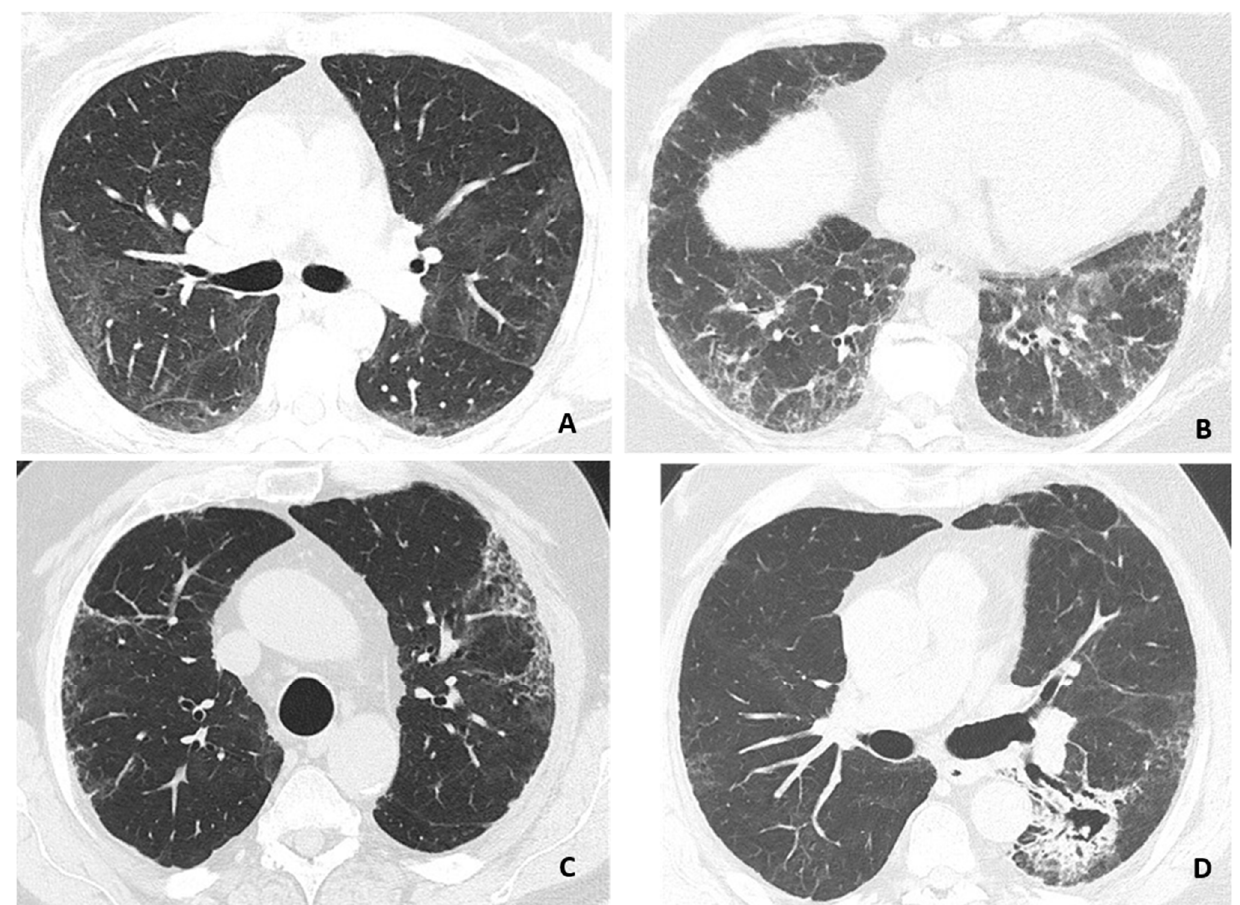
Figure 1. Representative findings on HRCT-scans. ( A ) Ground-glass opacity with discrete interlobular lines. ( B ) Ground-glass opacity with a reticular pattern. ( C ) Discrete ground-glass opacity with reticular pattern and honeycombing. ( D ) Fibrosis with traction bronchiectasis and infarct sequelae with possible fungus ball in the cavity. Images from three patients, ( C , D ) is from the same